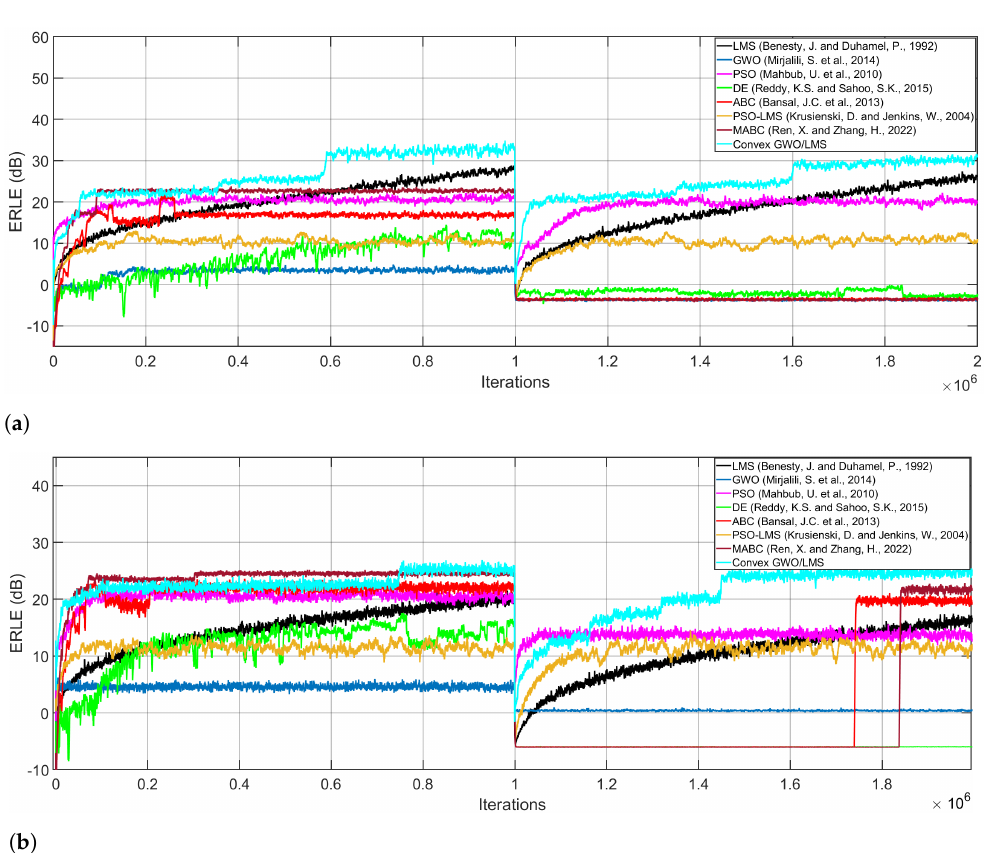
Figure 7. ERLE learning curves obtained by simulating existing approaches and the proposed algorithm; ( a ) by shifting the acoustic path at the middle of iterations and ( b ) by multiplying the acoustic path by − 1 at the middle of iterations [1,15,23,48–51].